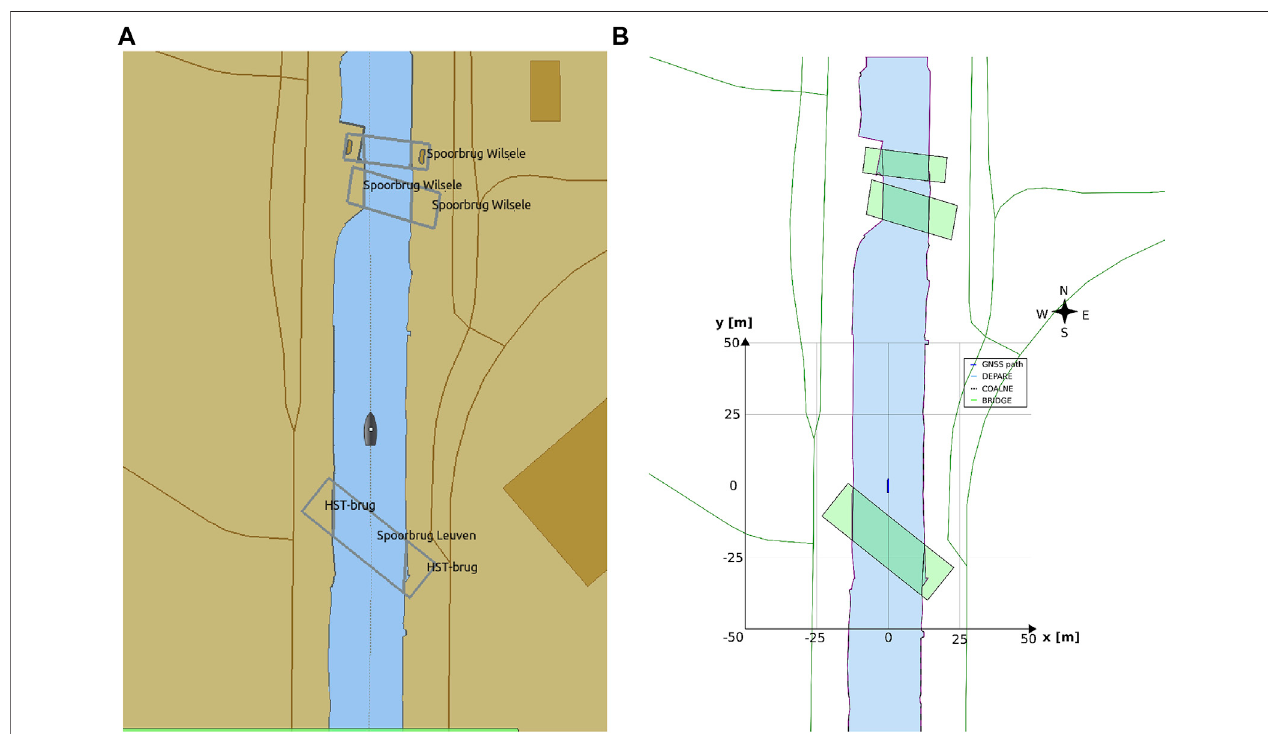
FIGURE2| OpenCPNECDISdisplay,withglobalENCfeaturesprojectedontoscreen (A) ,versusalocalmap (B) withfeaturesinlocalENUcoordinates,generated from global ENC dataset, displayed as a vector image (in SVG).